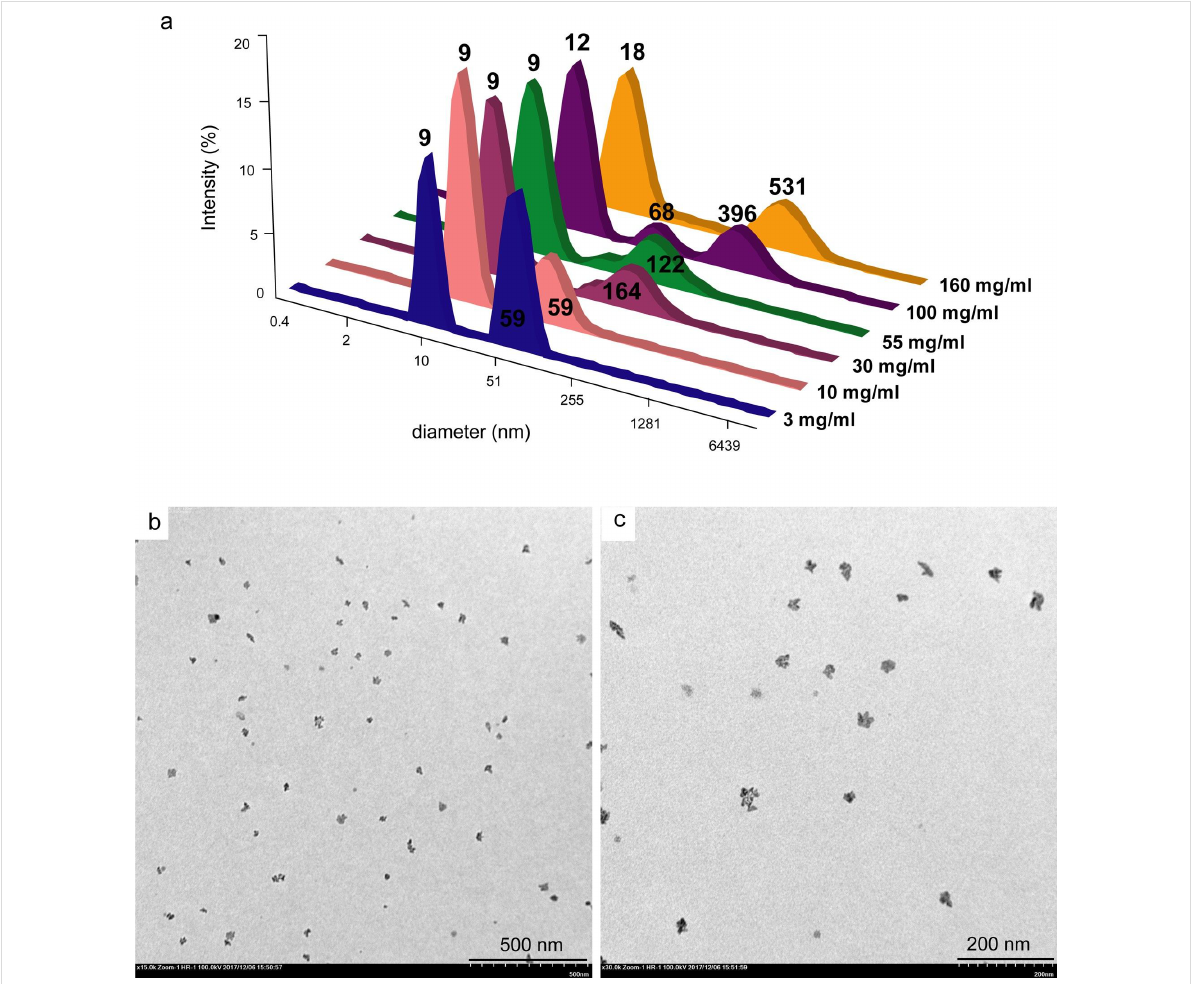
Figure 3: (a) The intensity-averaged particle size distribution of aqueous solutions of 3 at different concentrations; (b, c) TEM images of particles of 3 , scale bars: (b) 500 nm, (c) 200 nm, c 3 = 10 mg/mL).